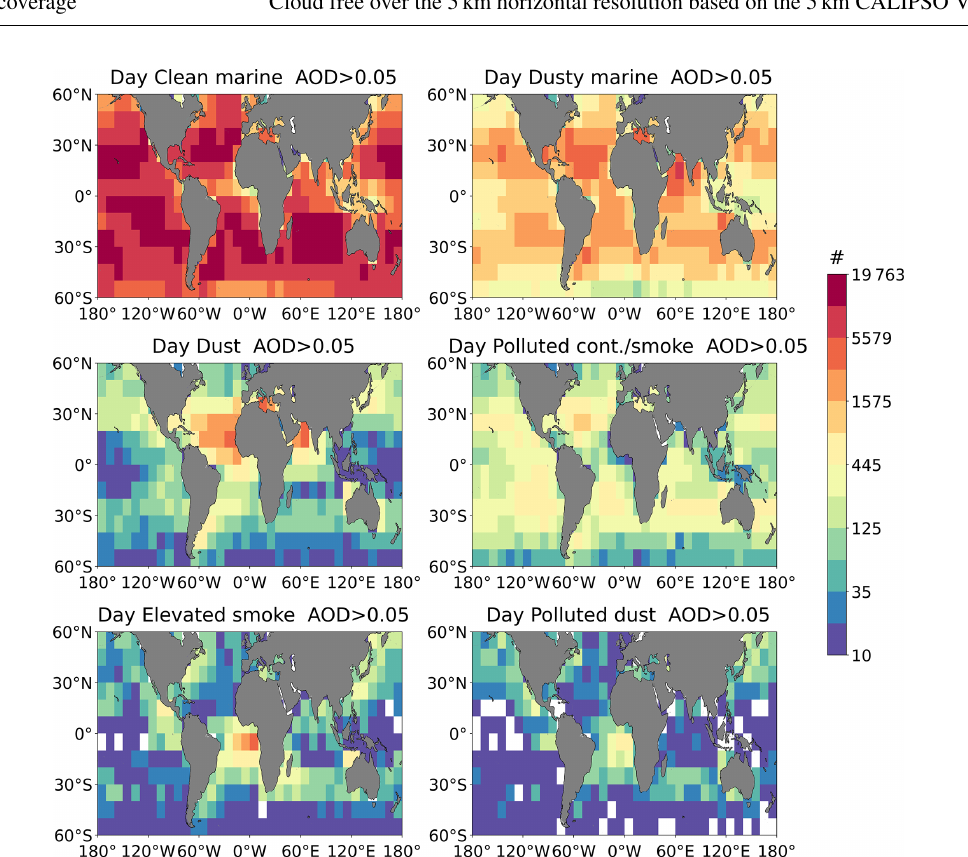
Figure 4. Geographical distribution of daytime number of samples used in this